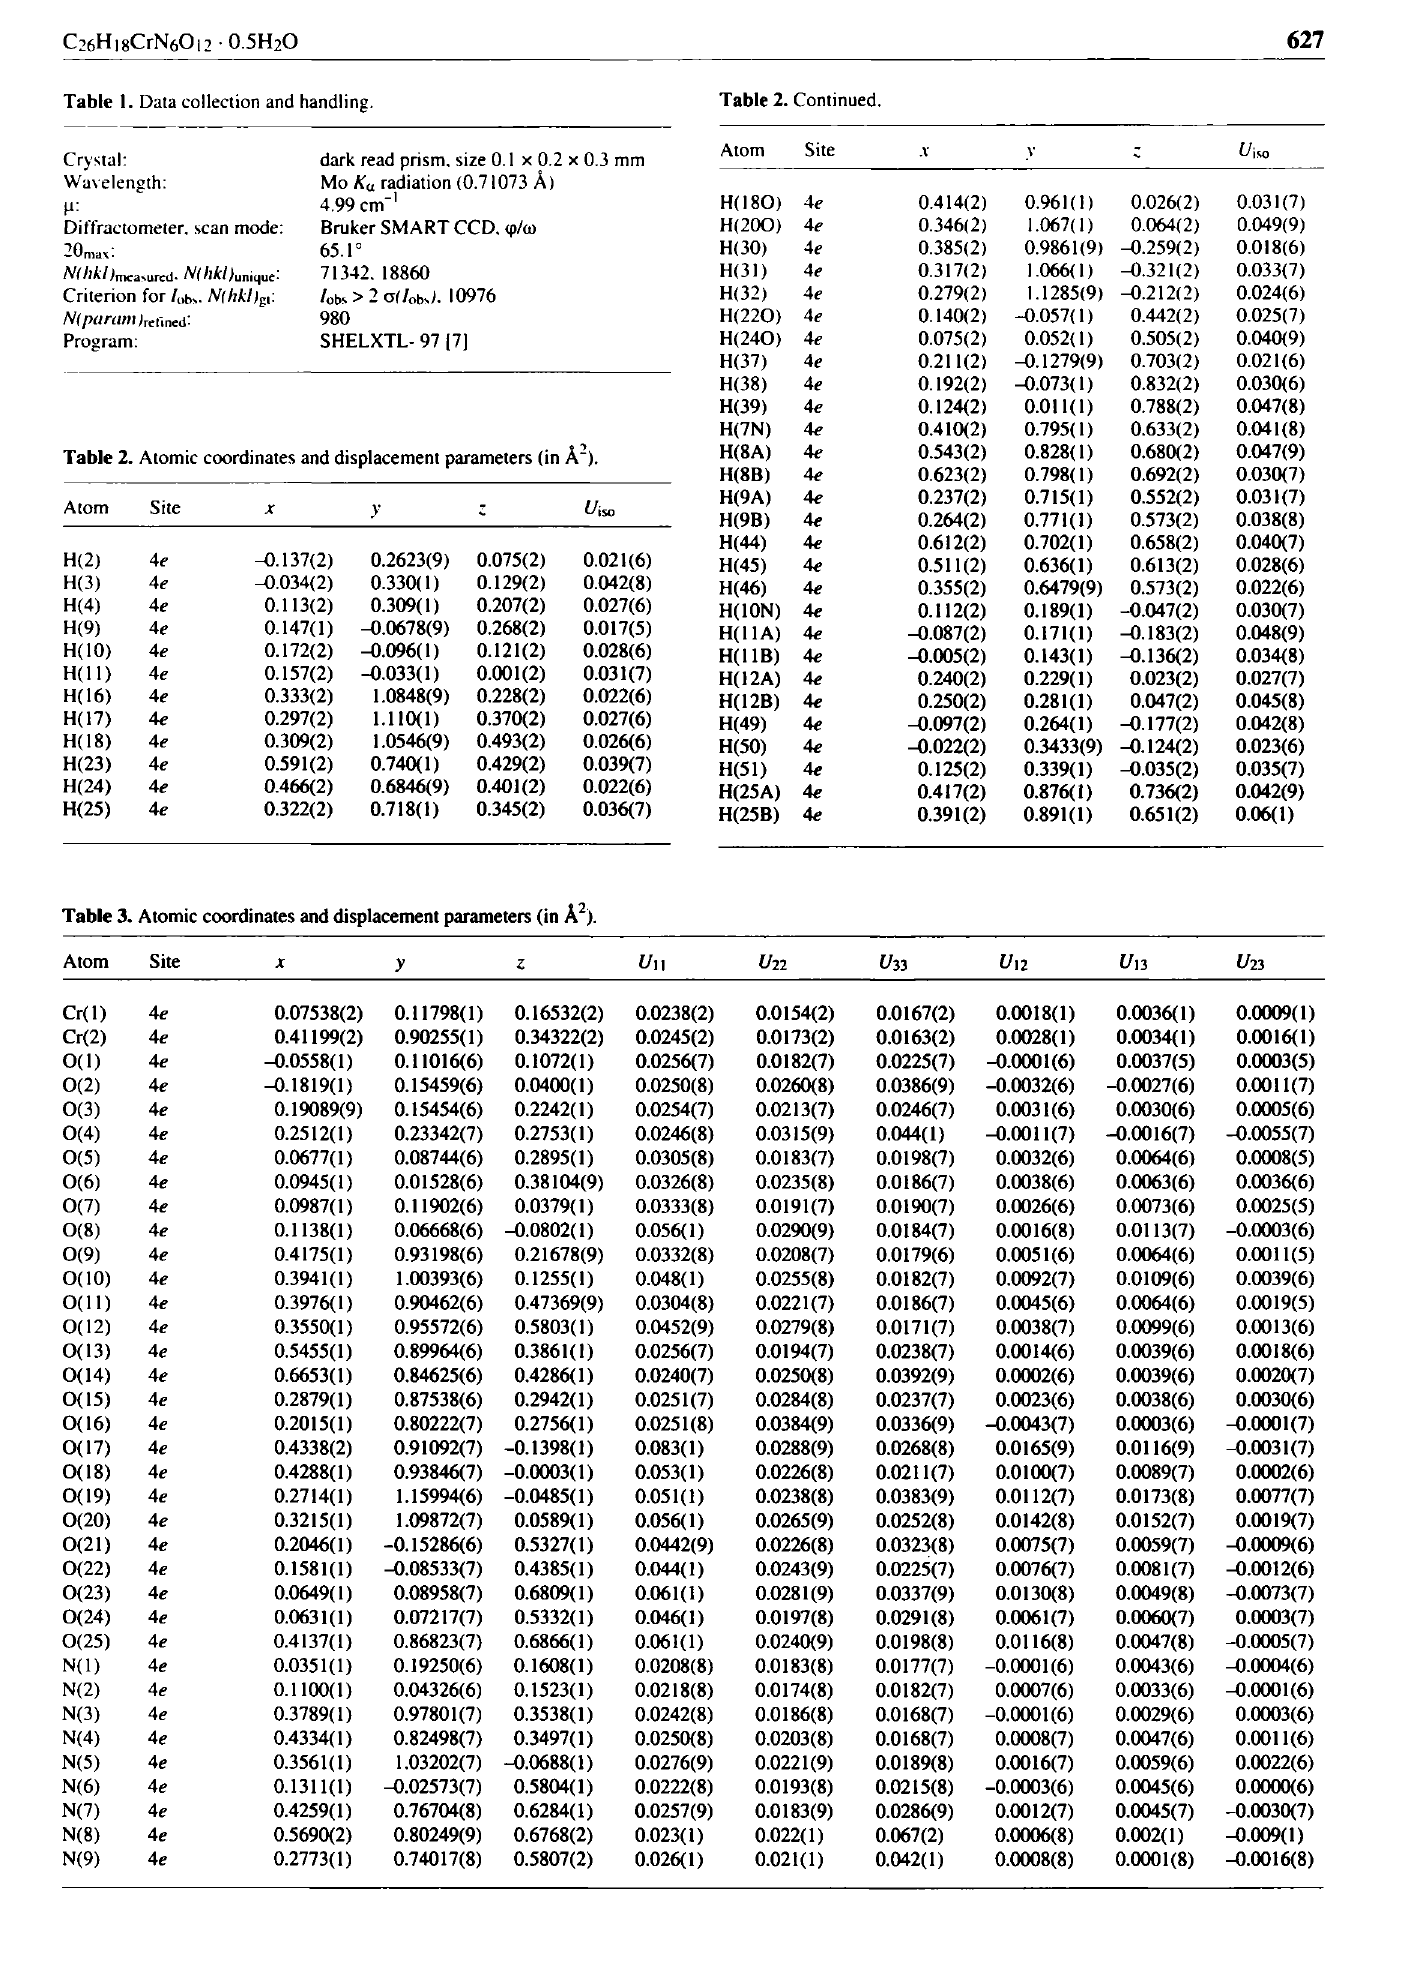
Table 1. Data collection and handling.